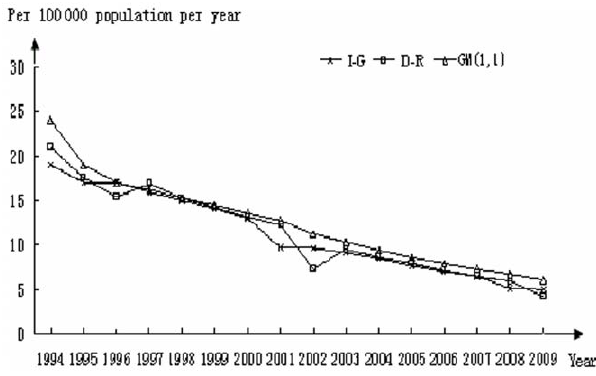
Figure 2. Incidence of tuberculosis in Germany; a comparison between actual (I-G) and calculated datasets using the D-R and